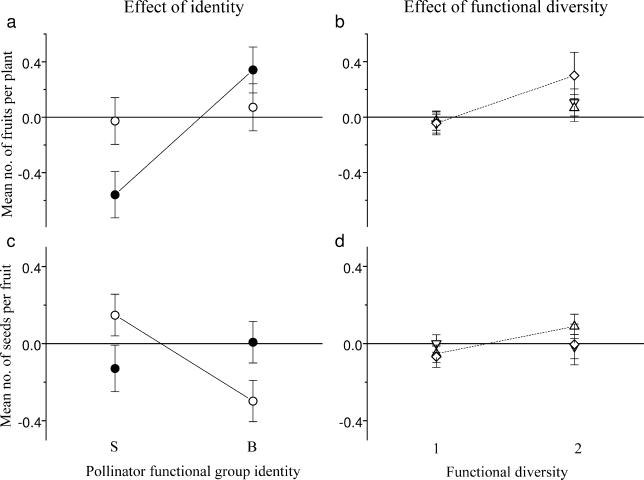
Effects of Pollinator Identity and Diversity on Plant Reproductive SuccessThe left panels show the effects of pollinator guild identity (S indicates syrphid flies, B indicates bumble bees) on the reproductive success of the two plant guilds (open circle indicates open-flowers [group 1], closed circle indicates tubular-flowers [group 2]). Reproductive success was measured by (A) the standardized number of fruits per plant and (B) the standardized number of seeds per fruit. The right panels show the effects of the functional diversity of pollination treatments (triangle), plant treatment (inverted triangle) and both (diamond) on the standardized numbers of fruits per plant (C) and seeds per fruit (D). Lines connecting symbols indicate significant effects (solid indicates p < 0.001, dashed indicates p < 0.08). Error bars represent one standard error. See Table 1 for statistical analysis.